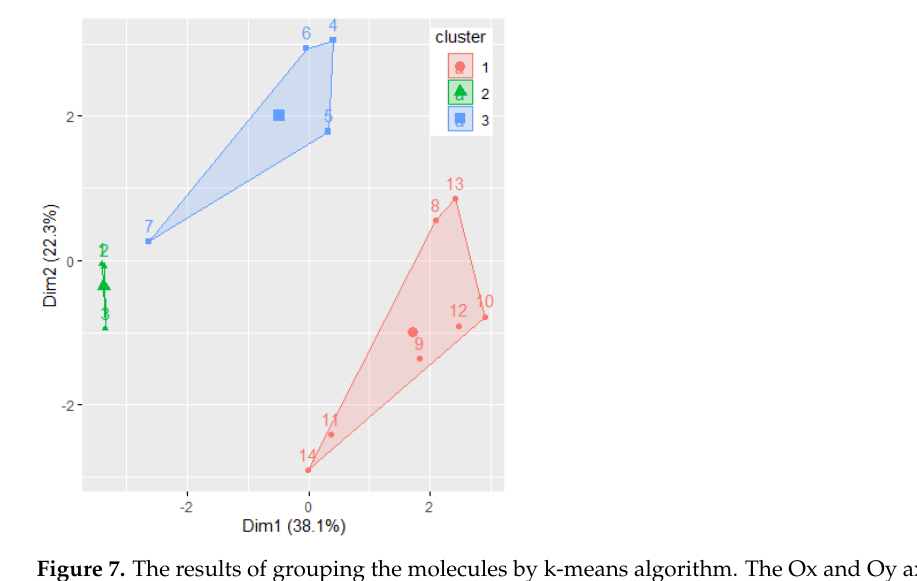
Table 7. Positive and negative effects of the Benzoylindoles that appear with probabilities greater than 0.5. Positive Effects